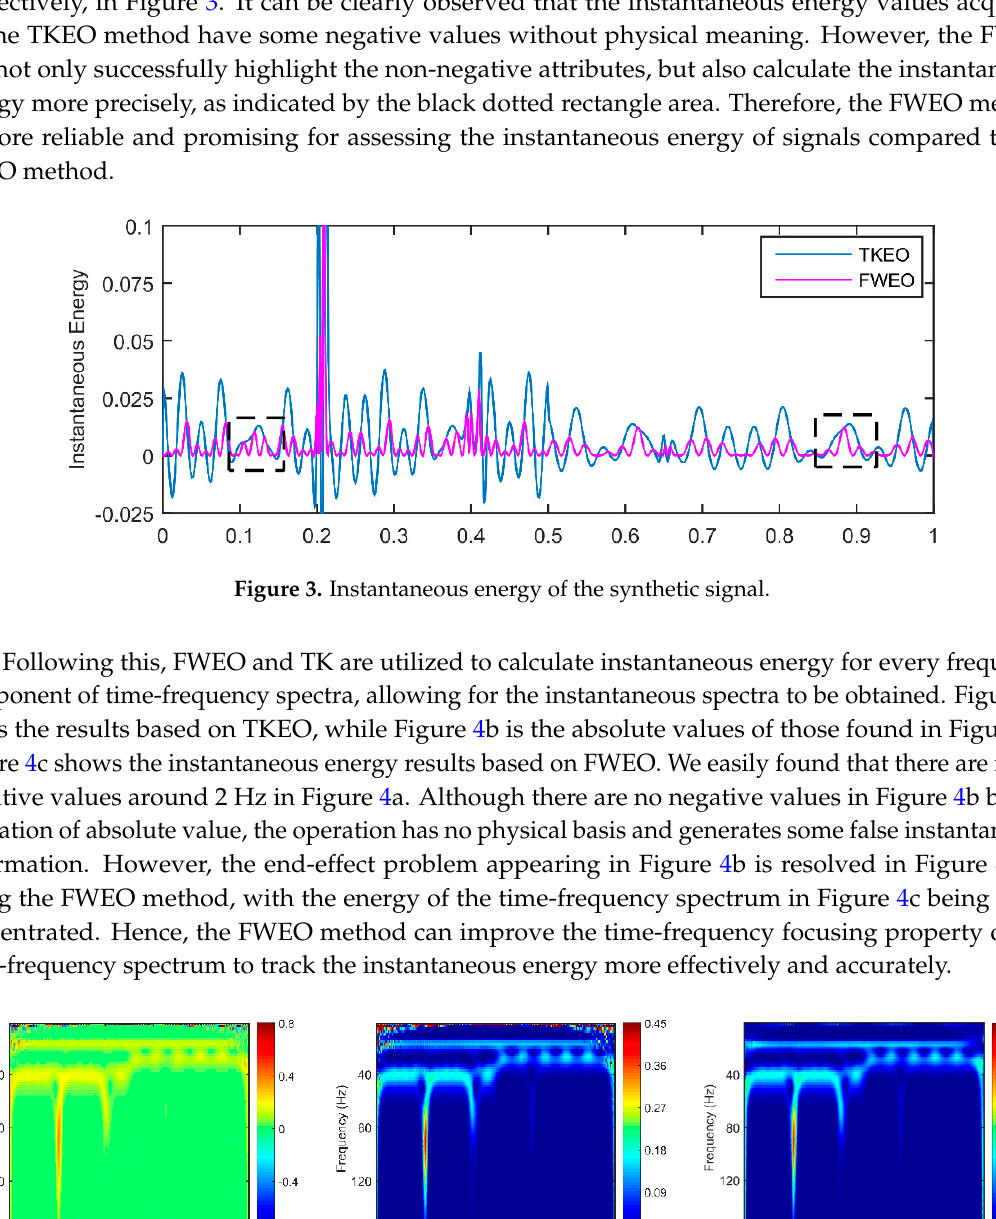
Figure 2. ( a ) Sub-signals; and ( b ) synthetic signal.